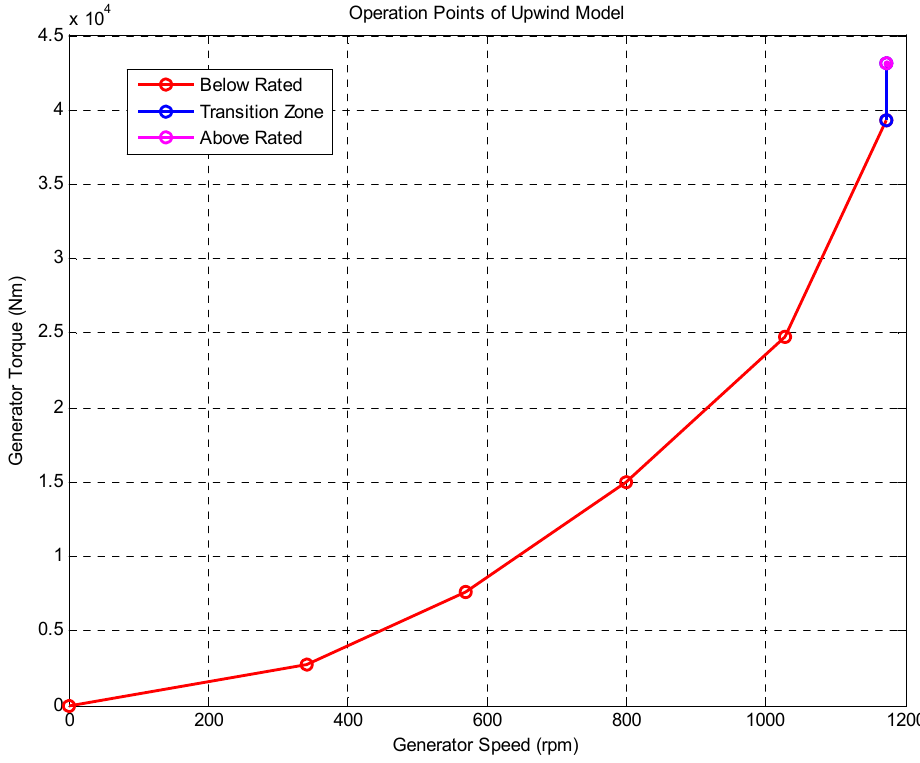
Figure 2. Curve of power production control zones for the Upwind wind